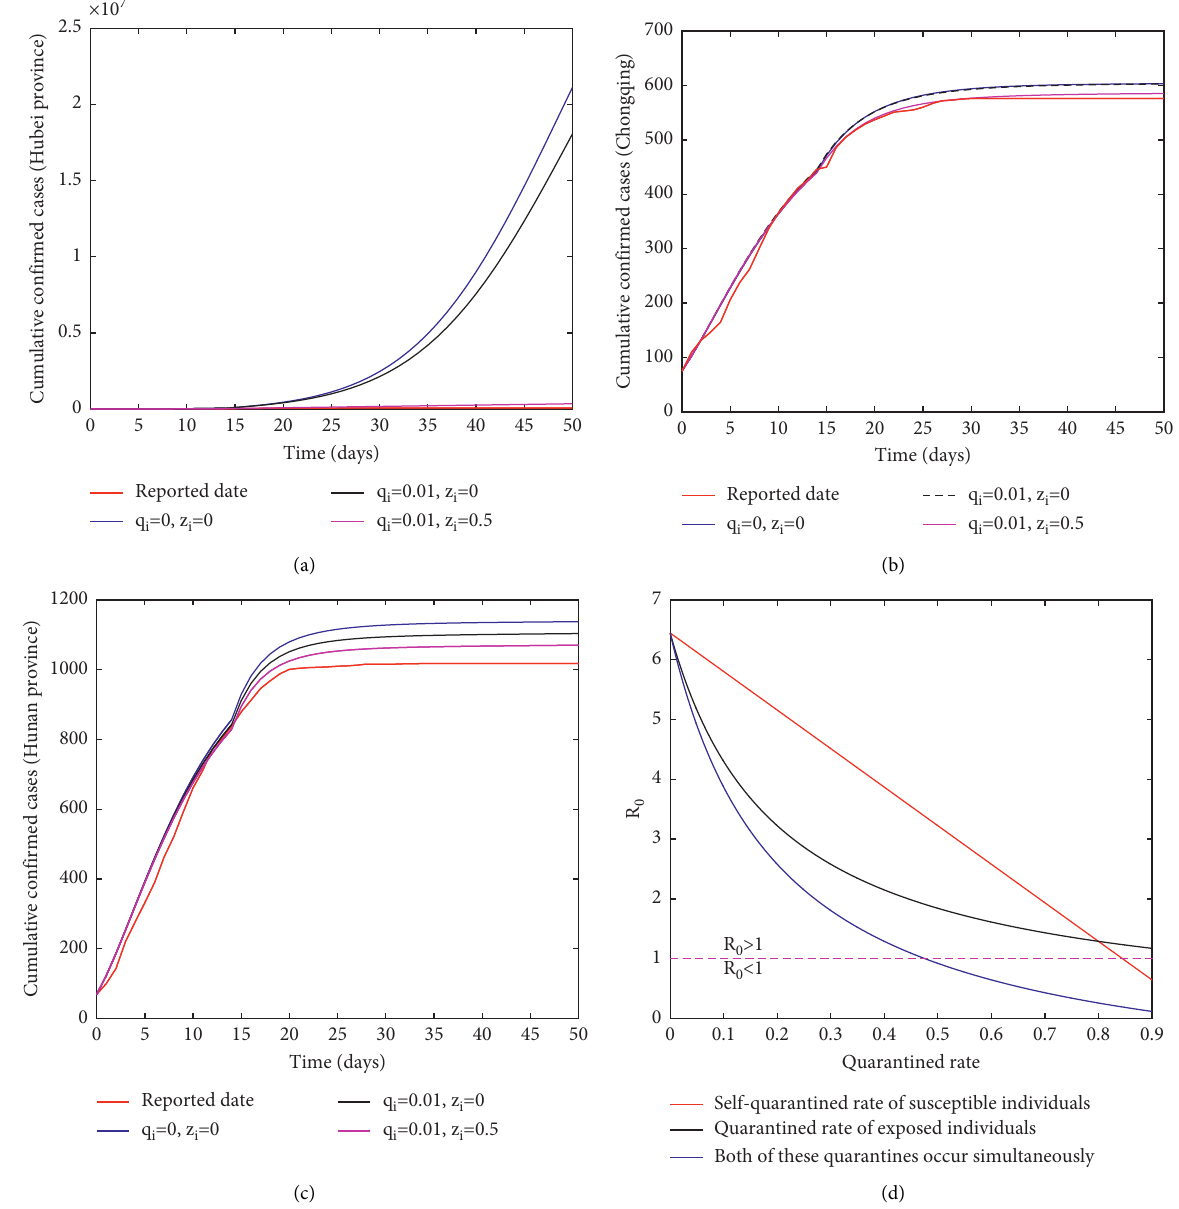
Figure 4: Effect of quarantined rate on COVID-19 transmission, where i � 1 , 2 , 3: (a) Hubei province; (b) Chongqing; (c) Hunan